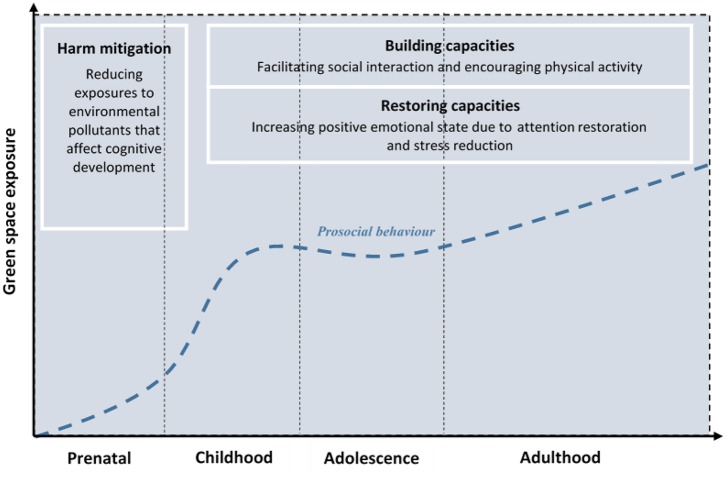
Potential pathways linking green space to prosocial behaviour. Adapted from Markevych et al. (2017) and Ben-Shlomo et al. (2014).